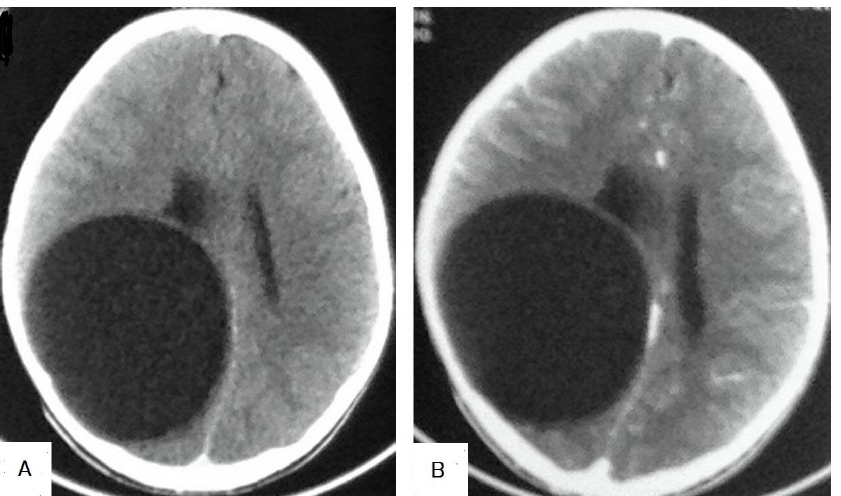
Figure 23. Selected CT images of a 12-year-old male presenting with signs of increased intracranial pressure, showing a large well-circumscribed cyst in the right cerebral hemisphere that caused a mass effect in the form of compression of the ipsilateral lateral ventricle complicating with ipsilateral hydrocephalus. The cyst showed no surrounding edema, no calcification ( A ), and no enhancement after contrast administration ( B ), which is a typical feature of cerebral hydatid cysts.